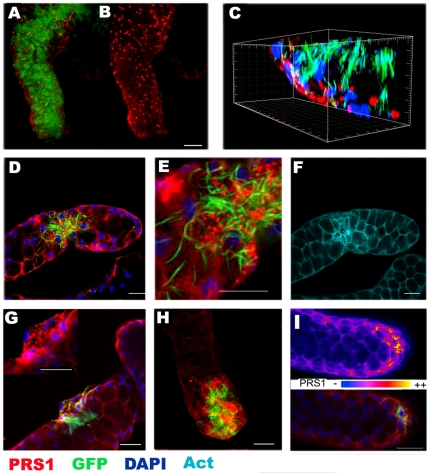
PRS1 overexpression in infected salivary glands.A–B. Z-stack projections of confocal sections for a highly infected salivary gland stained for PRS1 and GFP (A) or PRS1 alone (B).Note the granular pattern of PRS1 labeling. C. Three-dimension reconstruction of the gland shown in A/B, showing PRS1 localization in the basal (facing the hemolymph) side of the salivary cells. No PRS1 labeling can be observed in the central part of the gland. PRS1 labeling does not colocalize with sporozoite GFP-labeling. D–I. Confocal analysis of glands with localized sporozoite invasion. D: merge of PRS1, GFP and DAPI staining on a confocal section in a superficial plane of the gland. E: zoom view of the section observed in D. F: phalloidin labeling of the actin network for the same section as in D, revealing actin network reorganization in the invaded part of the gland. G: confocal section (middle plane; merge of PRS1, GFP and DAPI staining) of a gland characterized by a very localized invasion. PRS1 labeling in the infected zone at a higher magnification is given in the inset. H: Z-stack projection of confocal sections showing another example of localized infection, at the distal part of the salivary lobe. Note the higher intensity of PRS1 labeling in the infected part contrasting with the low level of labeling outside. I: PRS1 labeling in a false color representation (labeling intensity increasing from blue to yellow) (upper panel) and merge of PRS1, GFP and DAPI staining (lower panel) on a superficial section of a poorly infected gland. Bar: 20 µm.